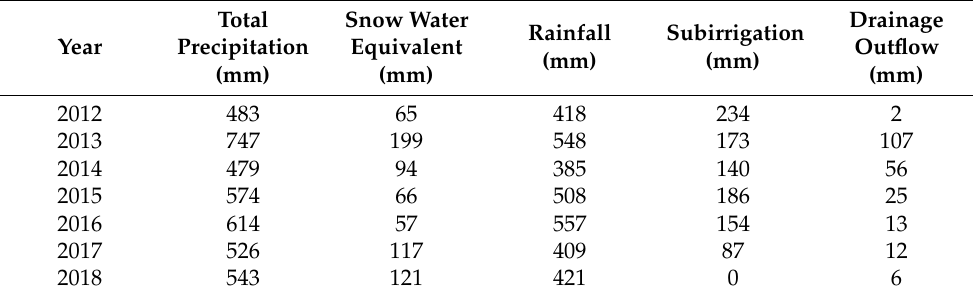
Table 1. Total annual precipitation, snow water equivalent from November to April, rainfall amount from May to October, subirrigation, and drainage outflow from the east sump pump at the Richland County, ND site. Drainage Snow Water Total Rainfall Subirrigation Outflow Equivalent Year Precipitation (mm) (mm) (mm) (mm)